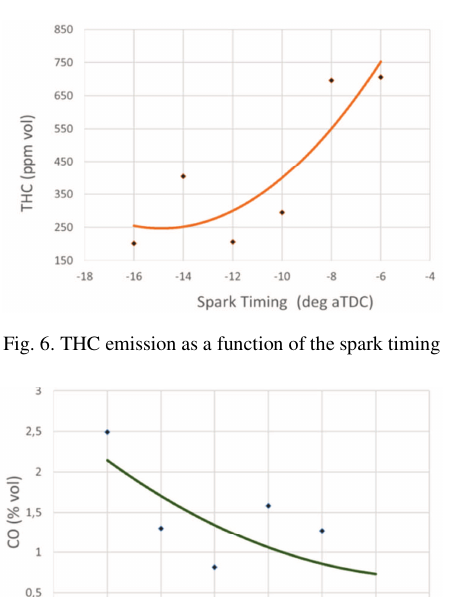
Fig. 10. Pressure rise rate in the function of the crank angle